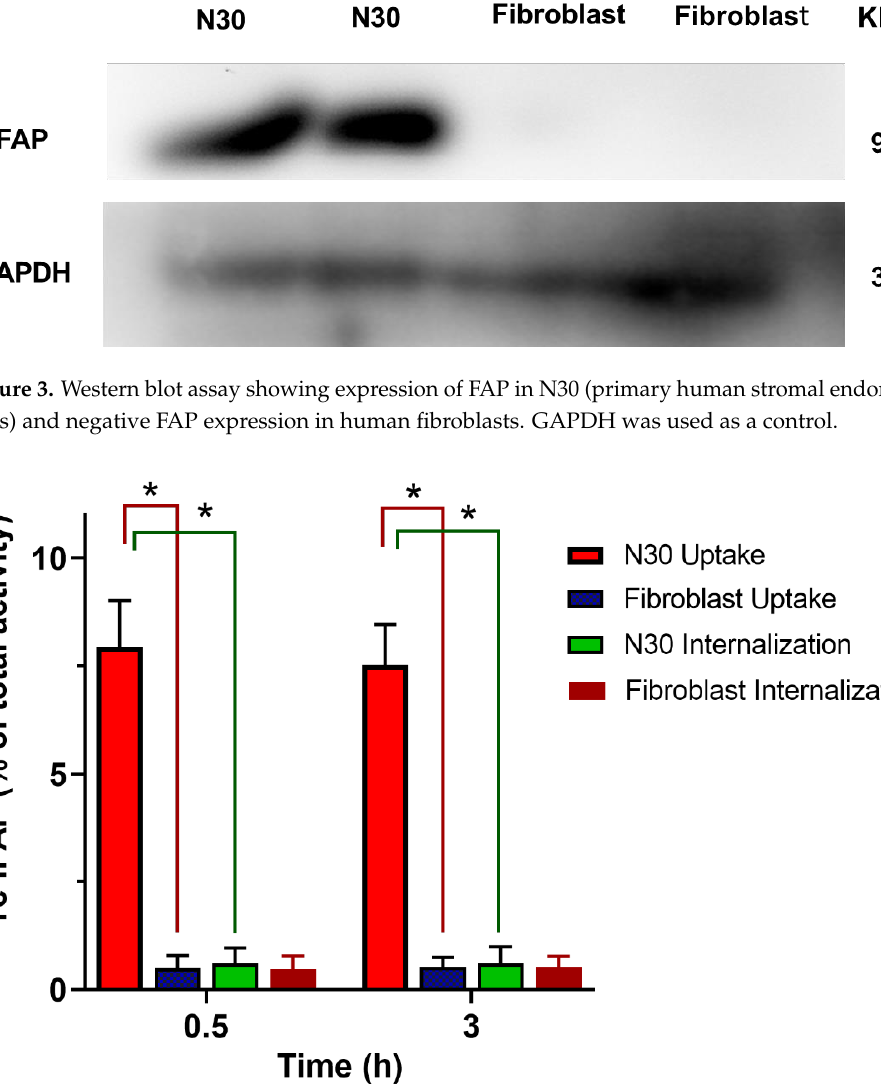
Figure 5. Microscopic fields (40×) of the in vitro uptake and internalization in the N30 cells (FAP- positive) of ( b ) Lu 2 O 3 -iFAP and ( e ) Lu 2 O 3 nanoparticles, detailing ( a , d ) the Hoechst-stained nucleus, and the merged images of nuclear and N30 cells treated with ( c ) Lu 2 O 3 -iFAP or (f) Lu 2 O 3 (control). Observe the qualitative difference regarding the number of lutetium oxide nanoparticles (bright spots) between the Lu 2 O 3 -iFAP ( b ) and nanoparticles without iFAP ( e ) in the membrane and cyto- plasm of N30 cells.